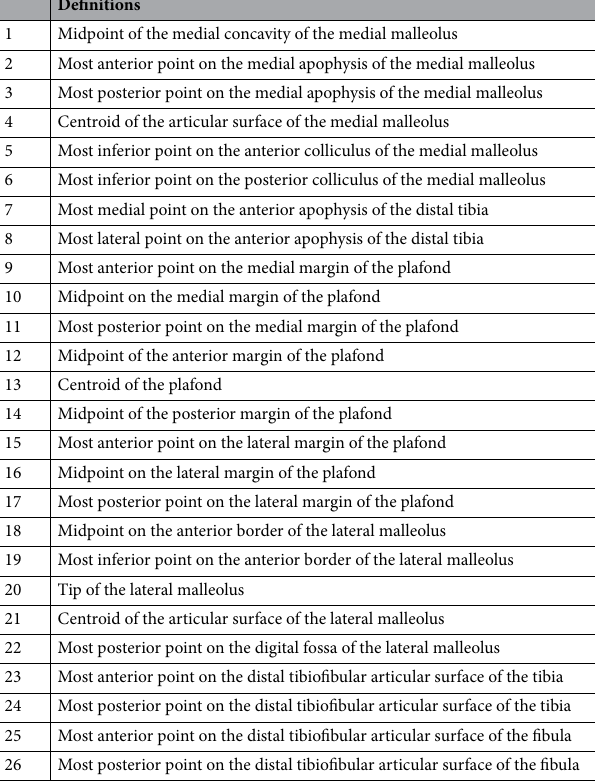
Table 1. The 26 landmarks used to define the regions of